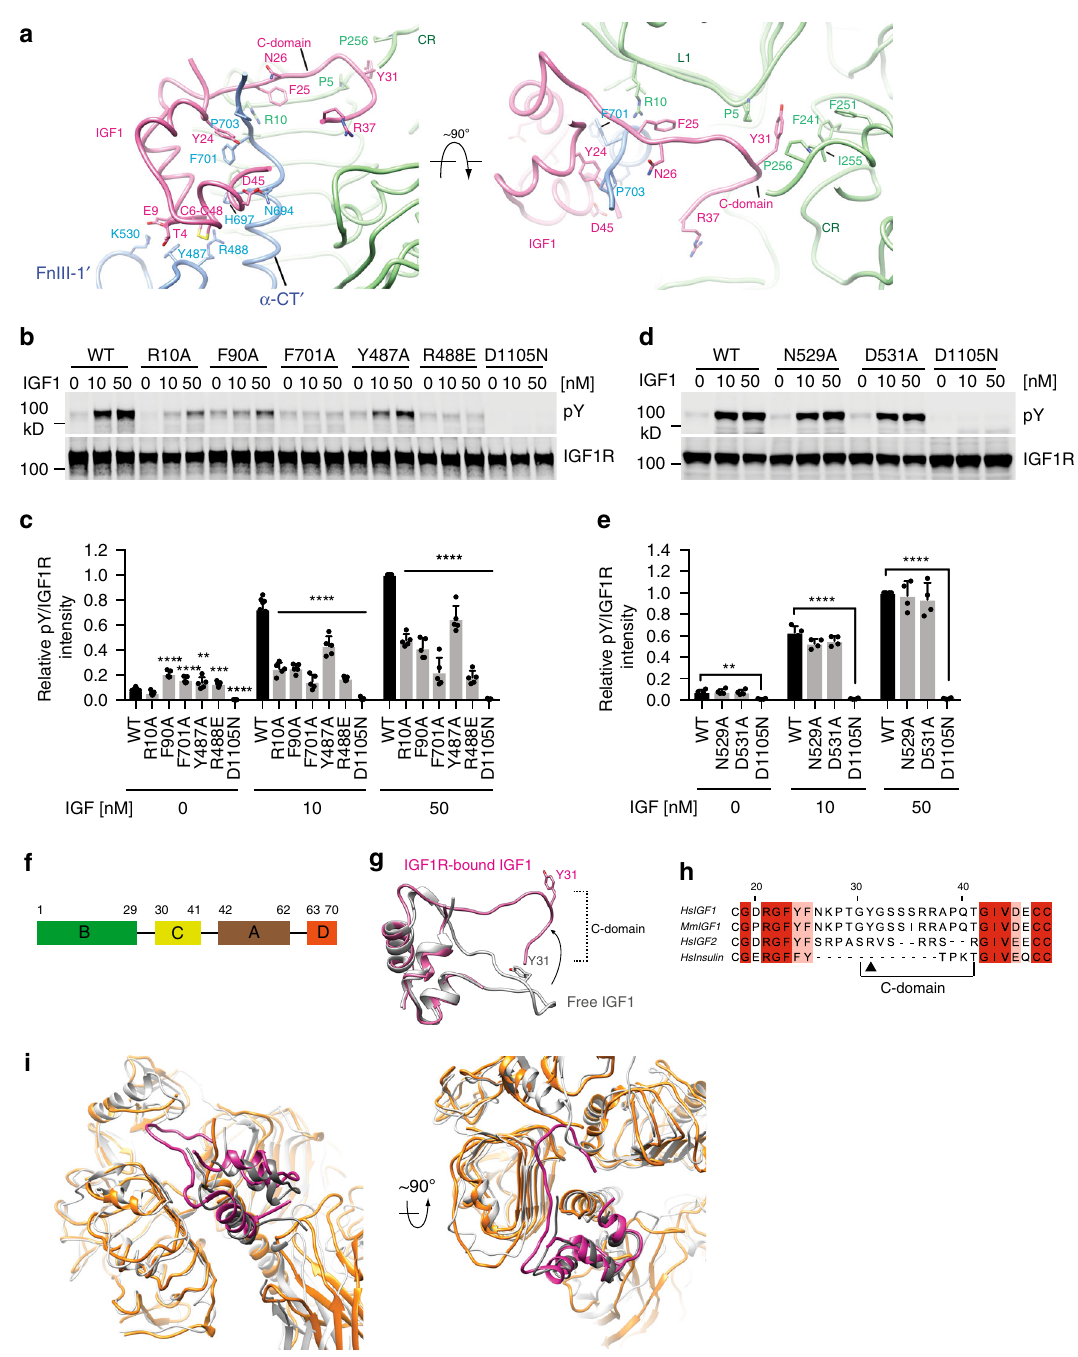
Fig. 3 IGF1 binding site in the active-IGF1R dimer. a Close-up view of the interaction between IGF1R and IGF1 in two orthogonal views. b IGF1-induced IGF1R autophosphorylation in 293FT cells expressing WT IGF1R or indicated mutants. The kinase dead mutant (D1105N) was used as a negative control. c Quanti fi cation of the western blot data shown in b (Mean ± SD). Each experiment was repeated fi ve times. Signi fi cance calculated using two-tailed students t-test; between WT and mutants; ** p < 0.01, *** p < 0.001, and **** p < 0.0001. d IGF1-induced IGF1R autophosphorylation in 293FT cells expressing WT IGF1R or indicated mutants. e Quanti fi cation of the western blot data shown in d (Mean ± SD). Each experiment was repeated four times. Signi fi cance calculated using two-tailed students t -test; ** p < 0.01 and *** p < 0.001. f Domain organization of IGF1. g Superposition between apo-IGF1 (gray) and IGF1 after binding IGF1R (pink), revealing the conformational change of C-domain (indicated by the arrow). h Sequence alignment of human IGF1, mouse IGF1, human IGF2, and insulin, showing the non-conserved C-domain. i Superposition between IGF1-bound IGF1R (pink and orange) and Insulin-bound IR (dark gray and light gray). Source data are provided as a Source Data fi